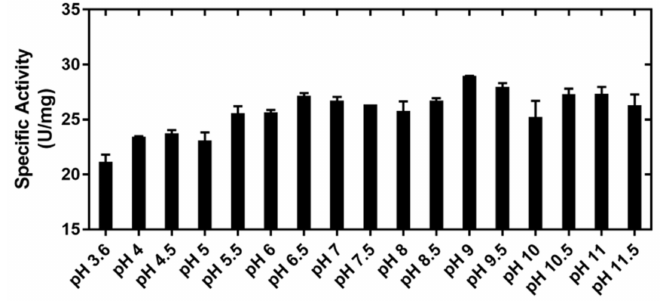
Figure 7. Specific activity (U/mg) of the bottom phase of ATPS in pH range of 3.6 to 11.5 using 2% ( w / v ) azocasein as substrate. The data represent the mean ± SD (N =